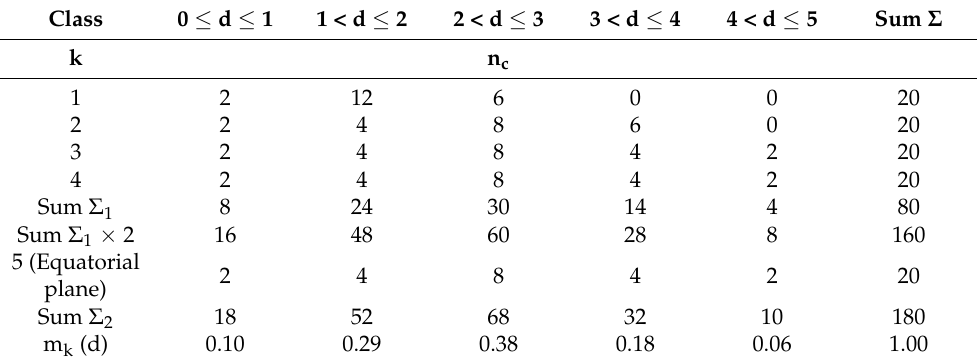
Table 4. A matrix for the numerical calculations of a number of circles’ diameters, d, in a